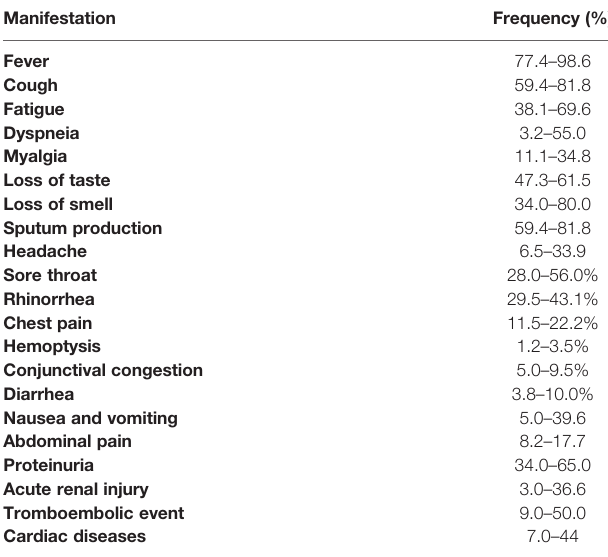
TABLE 1 | Clinical manifestations of COVID-19 according to several studies (Ge et al., 2020; Guan et al., 2020; Hirsch et al., 2020; Rodriguez-Morales et al., 2020; Coronavirus disease 2019 (COVID-19) pandemic: increased transmission in the EU/EEA and the UK — seventh update,